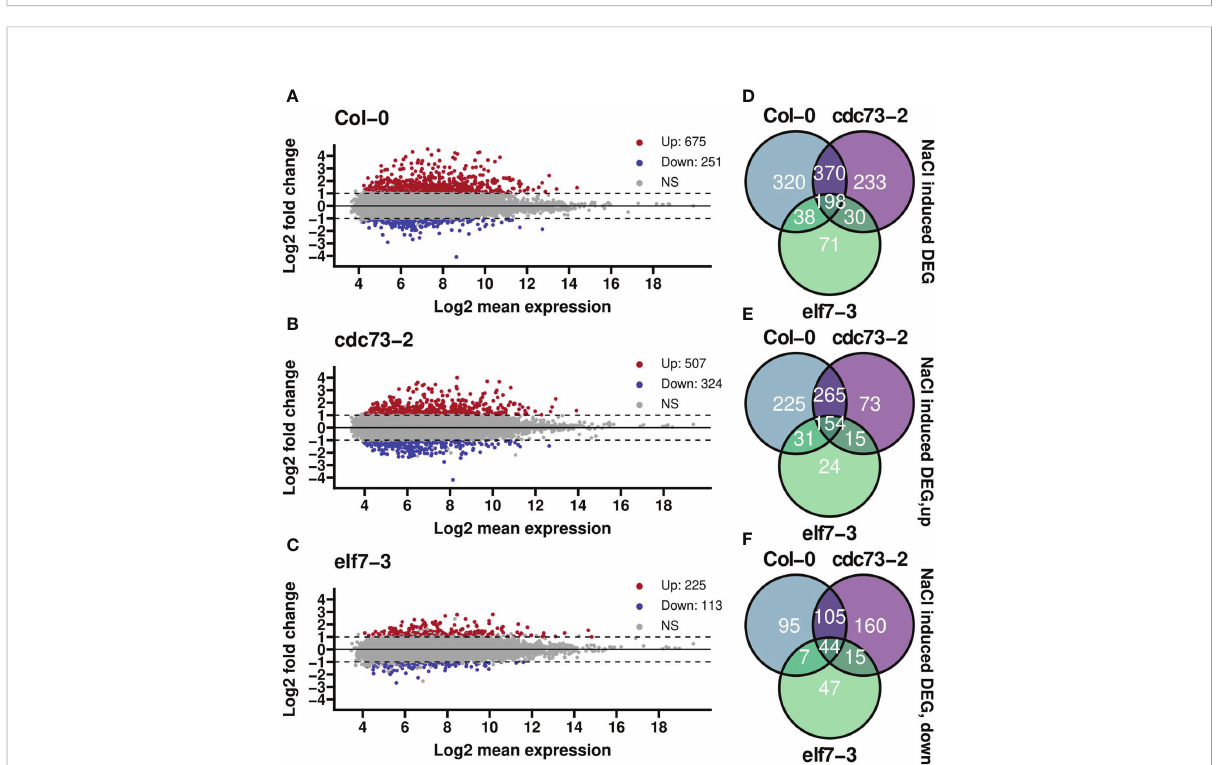
FIGURE 3 Differential gene expression analysis of elf7-3 and cdc73-2 relative to Col-0 upon NaCl treatment. (A – C) differential gene expression between treatment and control groups for each genotype separately. Highlighted in red are genes that are signi fi cantly upregulated after salt stress (log- fold change, LFC ≥ 1 and padjusted ≤ 0.05), while in blue are genes that are signi fi cantly downregulated upon NaCl exposure (LFC ≤ − 1 and padjusted ≤ 0.05). NS = not signi fi cant. Numbers in the legends represent the gene counts in that group. (D, E) Venn diagrams summarising the number of differentially expressed genes in the different genotypes (as in A – C ) upon NaCl treatment with total number of differentially expressed genes (D) , upregulated (E) or downregulated (F) genes. ns, not signi fi